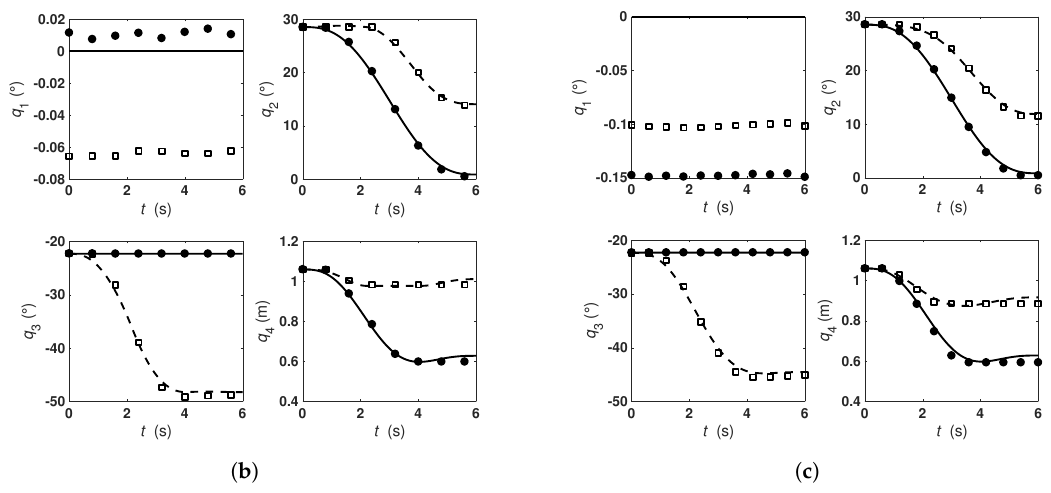
Figure 11. Vertical path: ( a ) Experimental constant-pressure and load-sensing system energy consumptions (smallest feasible extension cylinder length at the initial configuration); ( b ) load-sensing system: energy-optimal DIDO (CP) joint trajectories ( ) and controller tracking performance ( Sub-optimal DP (A. En.) joint trajectories ( ) and controller tracking performance ( (cid:151) ); and ( c ) constant-pressure system: energy-optimal DIDO (LS) joint trajectories ( ) and controller